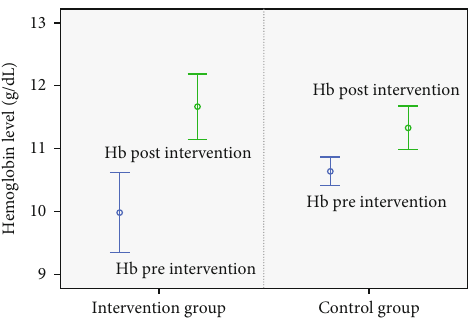
Figure 2: Changes in the percentage of mean of hemoglobin in both groups.